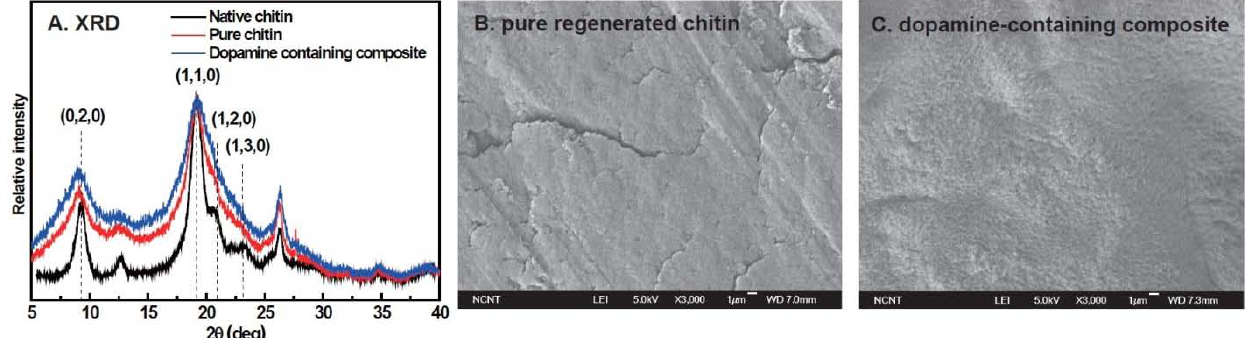
Figure 3. ( A ) X-ray diffraction (XRD) spectra of native chitin (black curve), pure regenerated chitin (red curve), 10 wt % dopamine-containing composite (blue curve); scanning electron microscope (SEM) images of ( B ) pure regenerated chitin; and ( C ) 10 wt % dopamine-containing